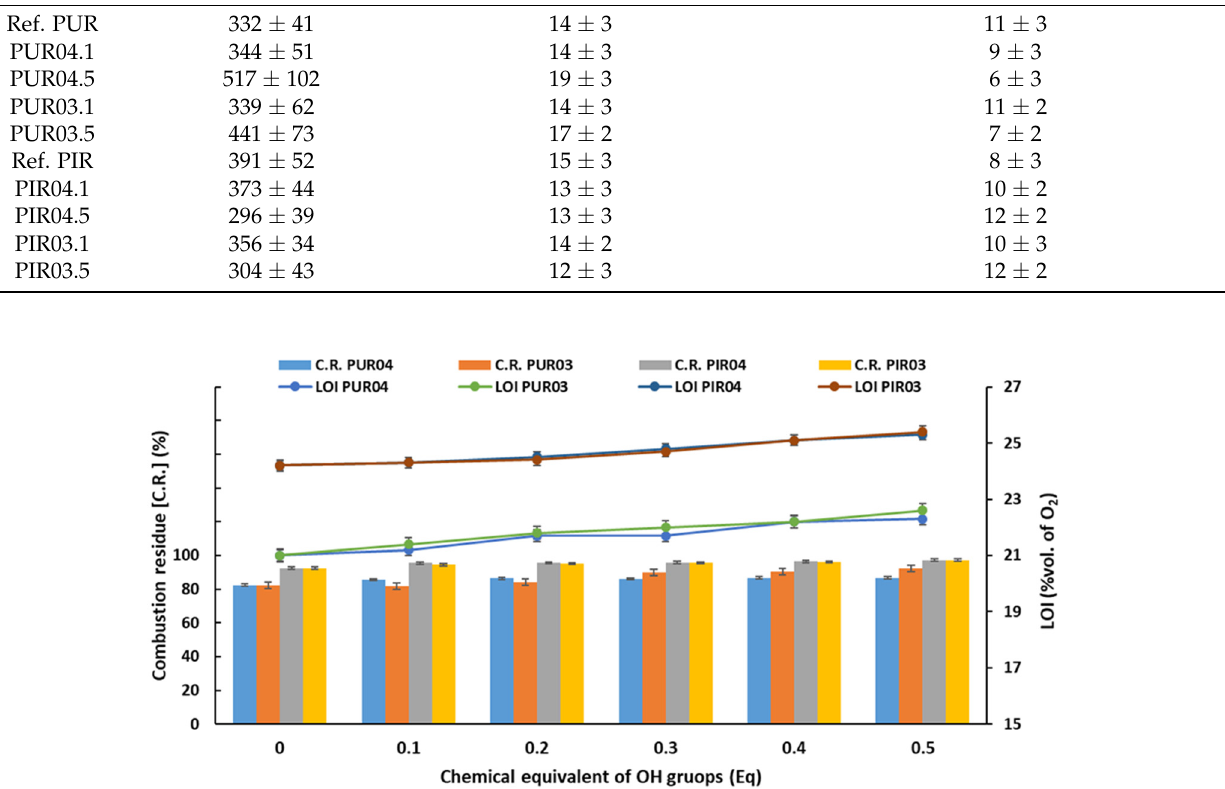
Figure 12. Dependence of the combustion residues (C.R.), limiting oxygen index (LOI) and the content of eco-polyols based on PLA waste.